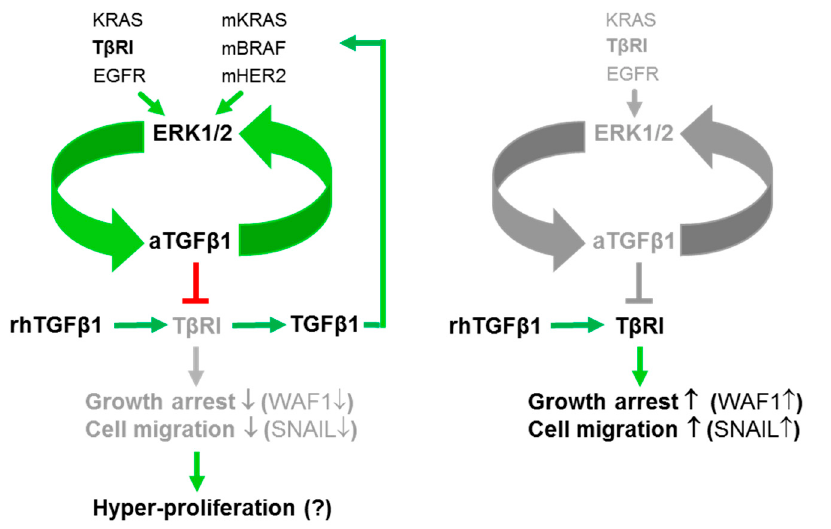
Figure 7. Cartoon illustrating the interactions of exogenous and endogenous/aTGF β that operate in PDAC- and TNBC-derived tumor cells. Left-hand side, the aTGF β 1 forms a regulatory feedforward loop with ERK1/2 to sustain high-level ERK activation. This circuit prevents exogenous TGF β 1 (rhTGF β 1 in vitro or paracrine and stromal cell derived-TGF β 1 in vivo) from inducing growth arrest or cell migration through T β R1/ALK5 via induction of p21 WAF1 (WAF1) or SNAIL, respectively. The aTGF β 1-ERK loop is driven by mutant (m) and wild-type versions of RAS, RAF, or EGFR/Erb-b2 receptor tyrosine kinase 2 (HER2) and additionally through T β RI/ALK5. Exogenous TGF β 1 also transcriptionally up-regulates TGFB1, and the resulting TGF β 1 protein via mutant RAS-ERK signaling can provide feedback inhibition of its own production. Right-hand side, in normal/benign cells, the aTGF β 1-ERK autoregulatory loop is non-functional due to the lack of mutant RAS/RAF proteins or lower expression or activation of T β RI/ALK5, but low-level activation of the aTGF β 1-ERK circuit is eventually achieved through EGFR activation via (wild-type) RAS. Green arrows denote activation or induction and red lines inhibition. Grey-shaded arrows/lines indicate